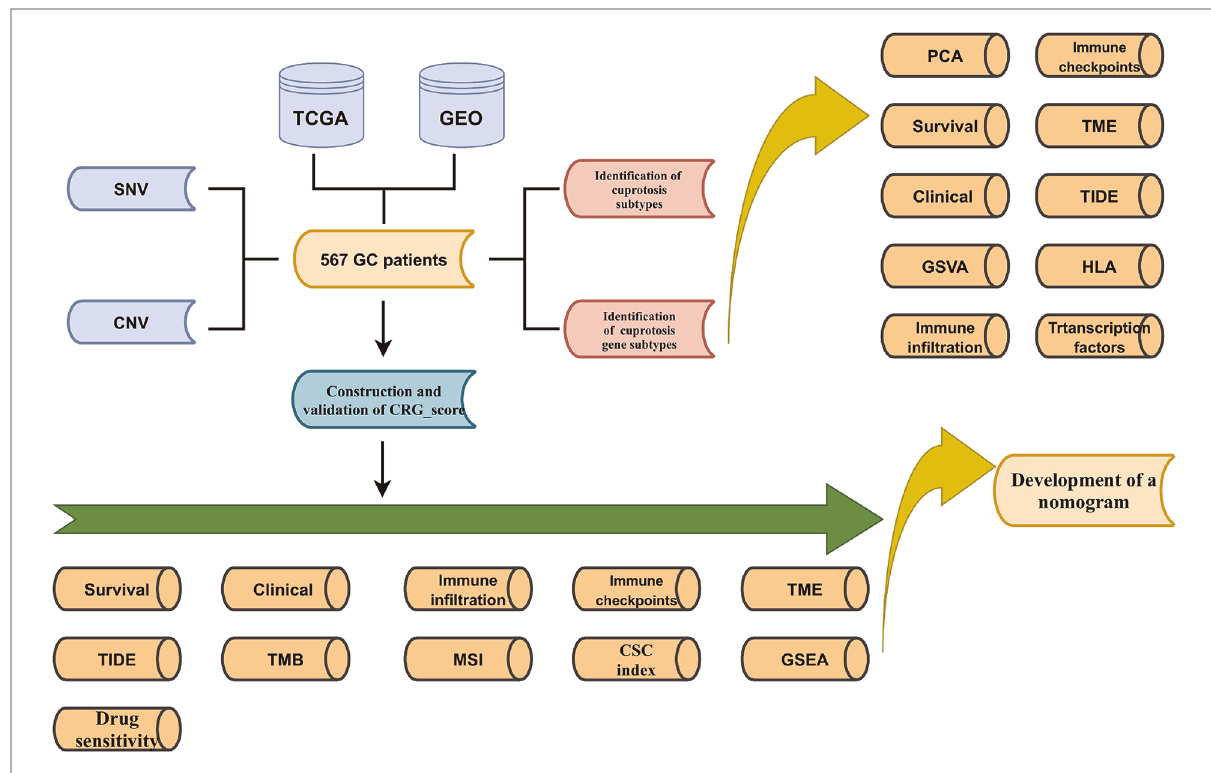
FIGURE 1 Schematic diagram of the fl ow of the